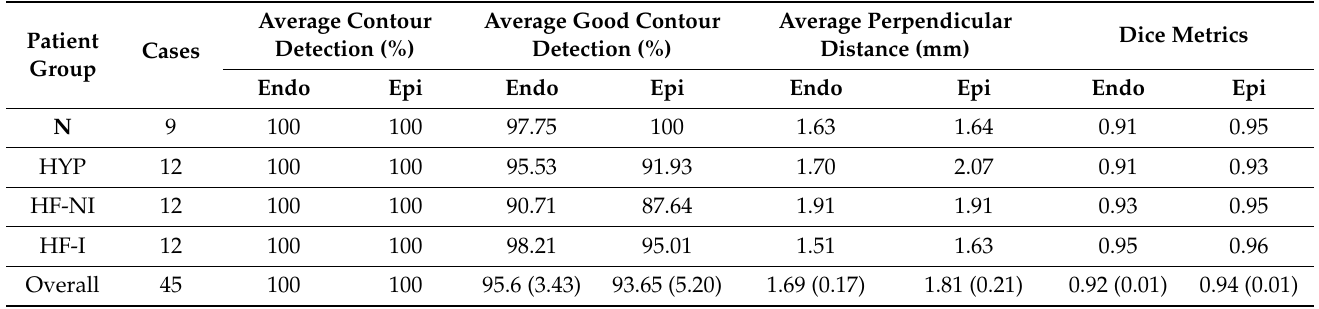
Table 11. Performance evaluation parameters for Tversky loss and Elu